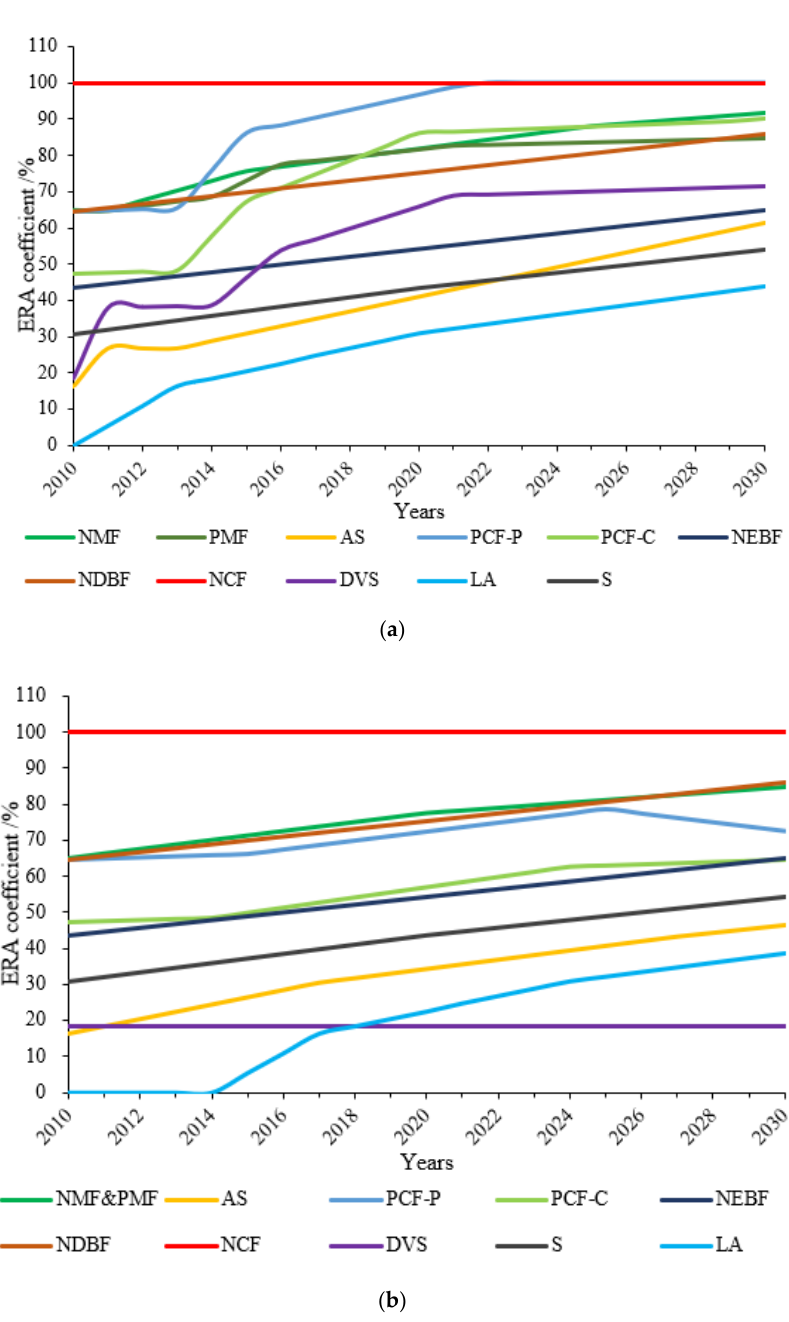
Figure 5. ERA coefficients of different land cover types under ( a ) natural and ( b ) artificial restoration measures from 2010 to 2030. NMF: natural mixed forest; PMF: planted mixed forest; AS: Alpine shrub; PCF-P: planted coniferous forest— Picea asperata ; PCF-C: planted coniferous forest— Cupressus chengiana ; NEBF: natural evergreen broad-leaved forest; NDBF: natural deciduous broad-leaved forest; NCF: natural coniferous forest; DVS: dry valley shrub; LA: landslide area; S: shrub. Based on the layouts of the forest restoration measures and the forest cover map of the Upper Zagunao watershed in 2010, coupled with ERA coefficients for each forest type under specified restoration measures, the future forest landscape changes were simulated and predicted by the ERA model in the forest change simulation and prediction module of FWAT. As shown in Figure 7 and Table 4, the upper Zagunao watershed was mainly covered by natural mixed forest (20.25%), planted coniferous forest (5.77%), natural conif- erous forests (4.95%), planted mixed forest (4.57%), natural evergreen broad-leaved